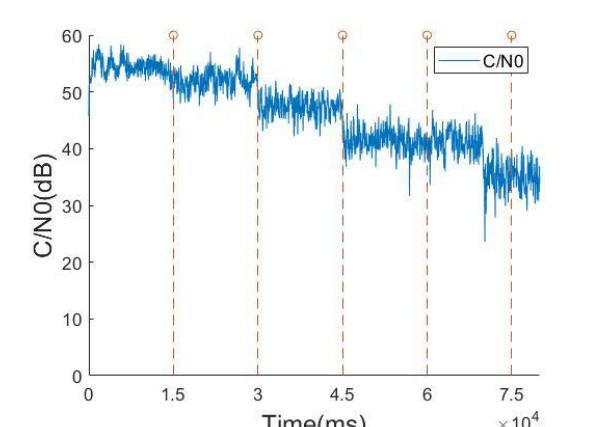
Figure 2. GPS signal C/N0